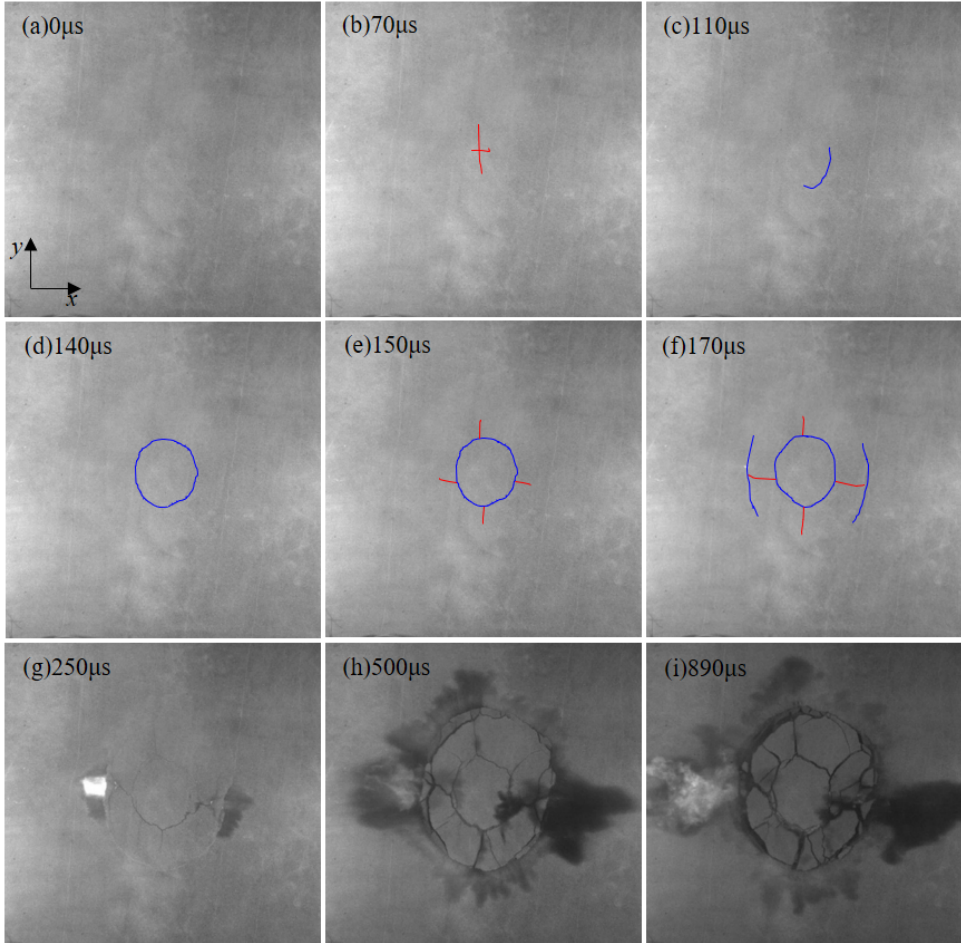
Figure 5. The crack network at different times during crater blasting under an SSR of 0.15. ( a – i ) The crack network after 0, 70, 110, 140, 150, 170, 250, 500, and 890 μs of explosion, respectively. crack network after 0, 70, 110, 140, 150, 170, 250, 500, and 890 µ s of explosion,